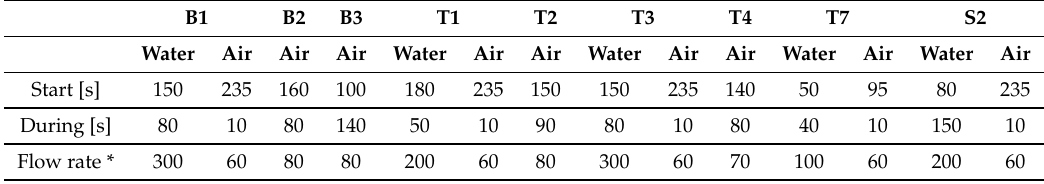
Table 2. Cooling parameters of the production process conditions.